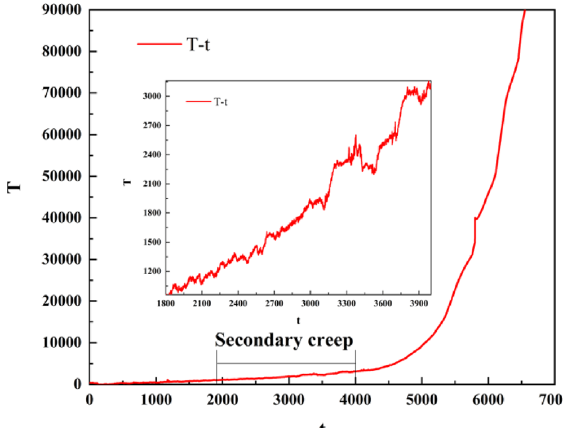
Figure 7. T–t curve after a coordinate